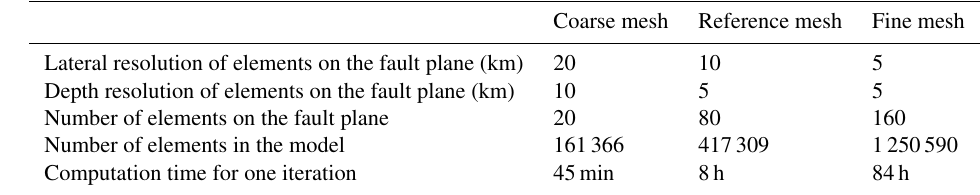
Table A1. Details of the meshes used in the sensitivity test.